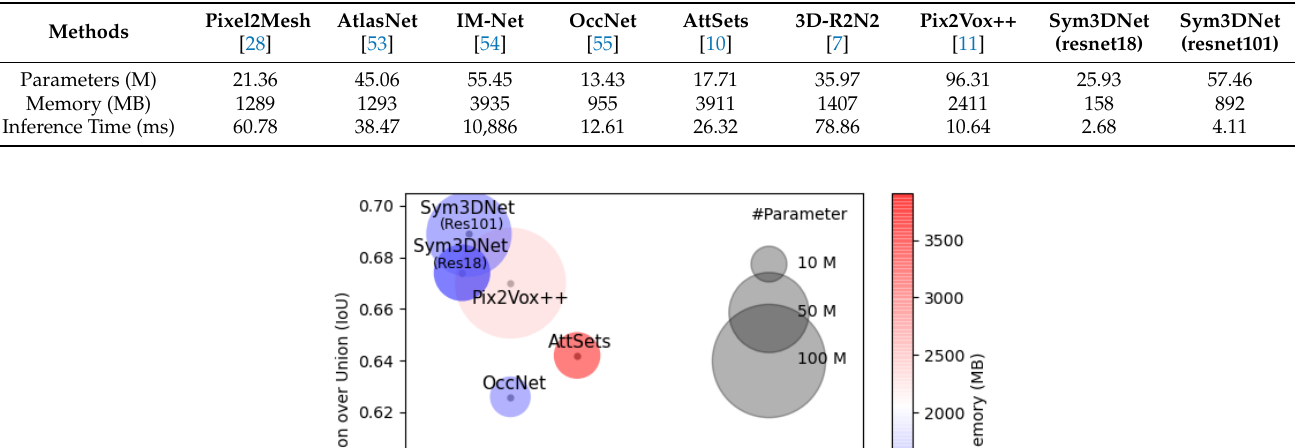
Table 7. Comparison of our method in terms of memory, time inference, and number of parameters with state-of-the-art methods. The memory is calculated considering the backward computation with batch size of 1.